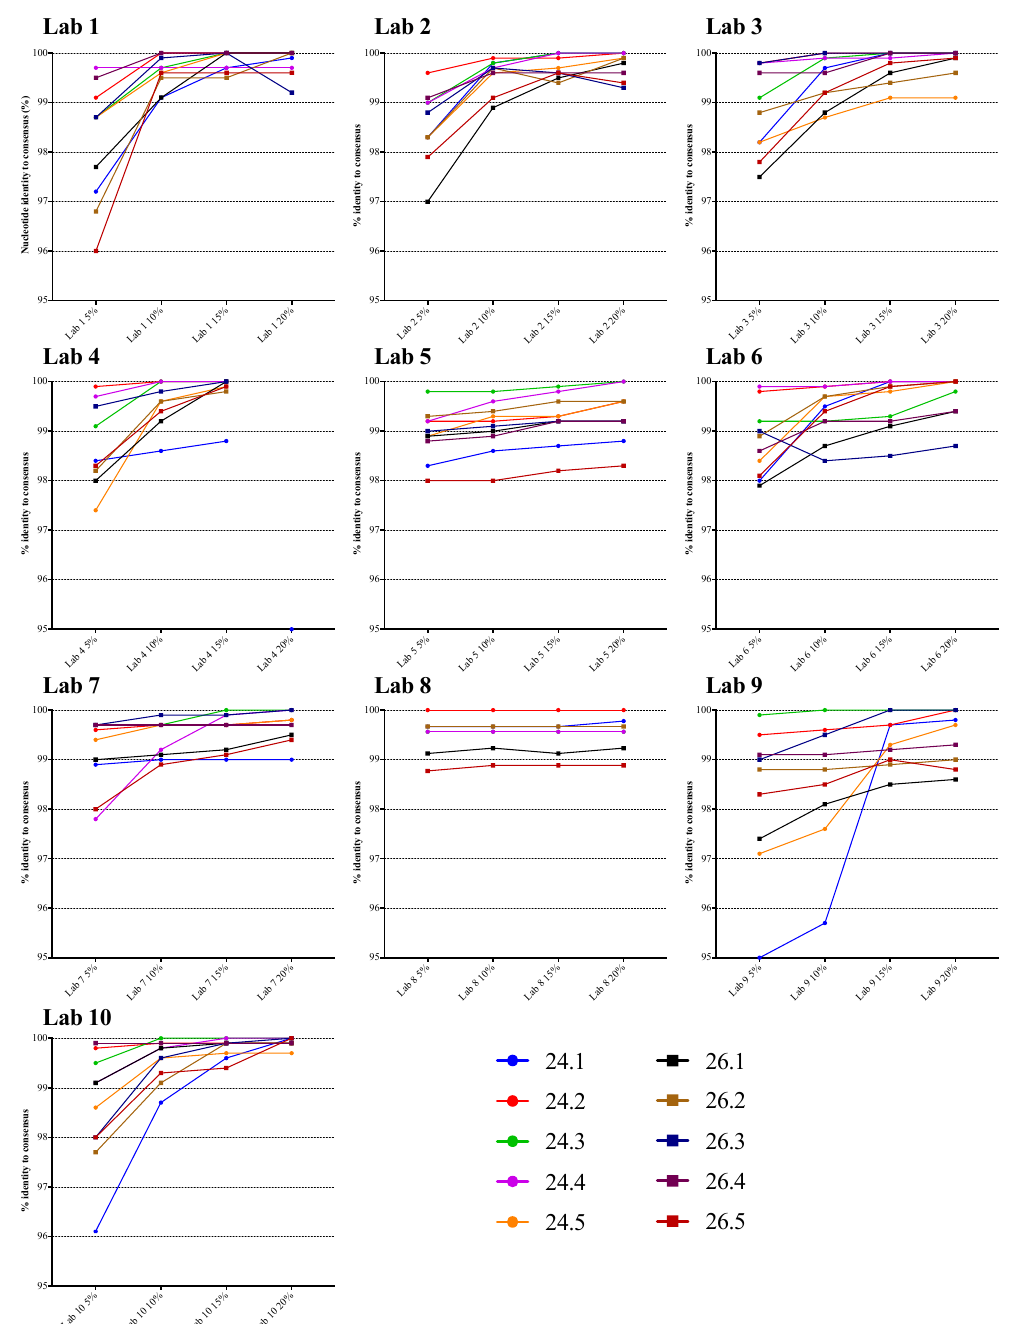
Figure 1. Plots of next-generation sequencing (NGS)-derived PR-RT nucleotide sequence identity vs. VQA Sanger consensus at various thresholds. Each line represents one specimen from panel 24 (24.1 through 24.5) or 26 (26.1 through